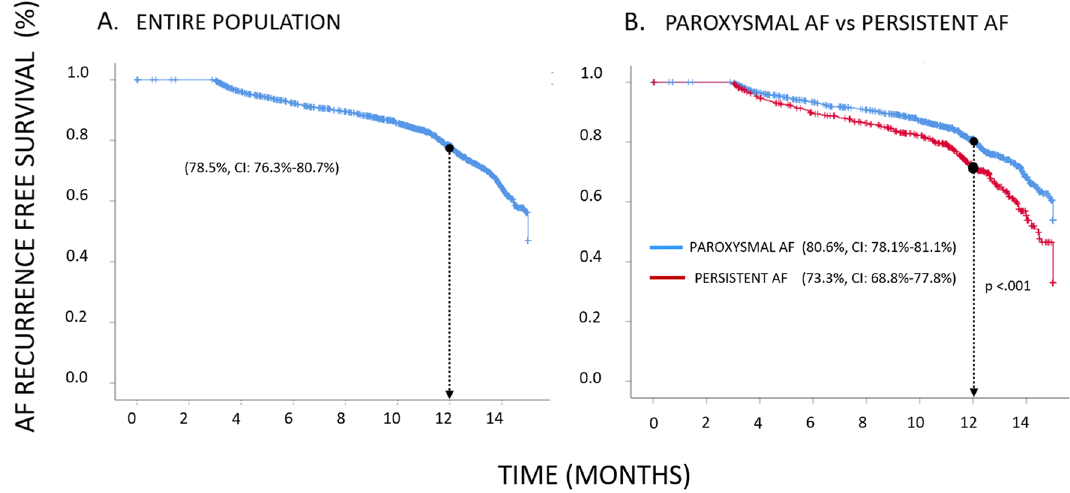
Figure 3. Kaplan–Meier survival curves for AF recurrence at 12-months for all patients ( A ). Comparison between PAF versus perAF ( B ).